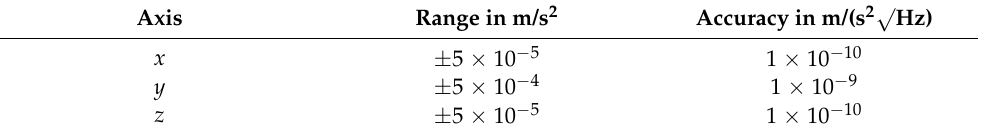
Table 1. SuperSTAR accelerometer specification. Axis